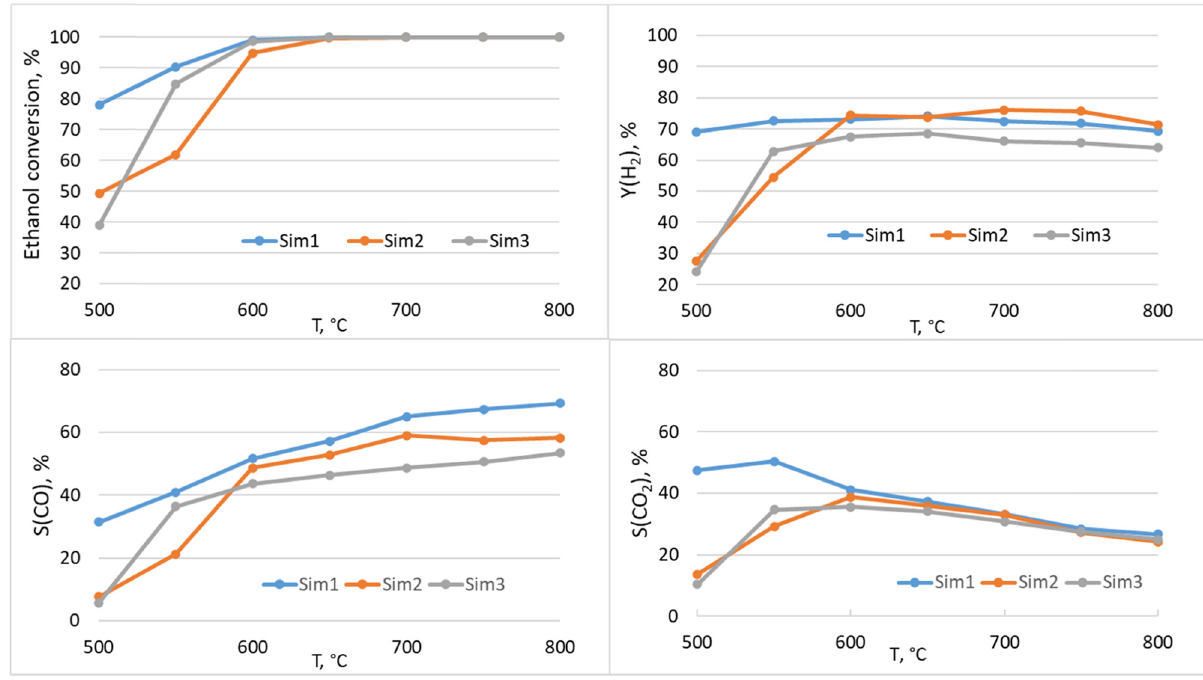
Figure 6: Temperature dependence of ethanol conversion, hydrogen yield, CO and CO 2 selectivities for Sim1, Sim2 and Sim3 in ethanol steam reforming reaction.